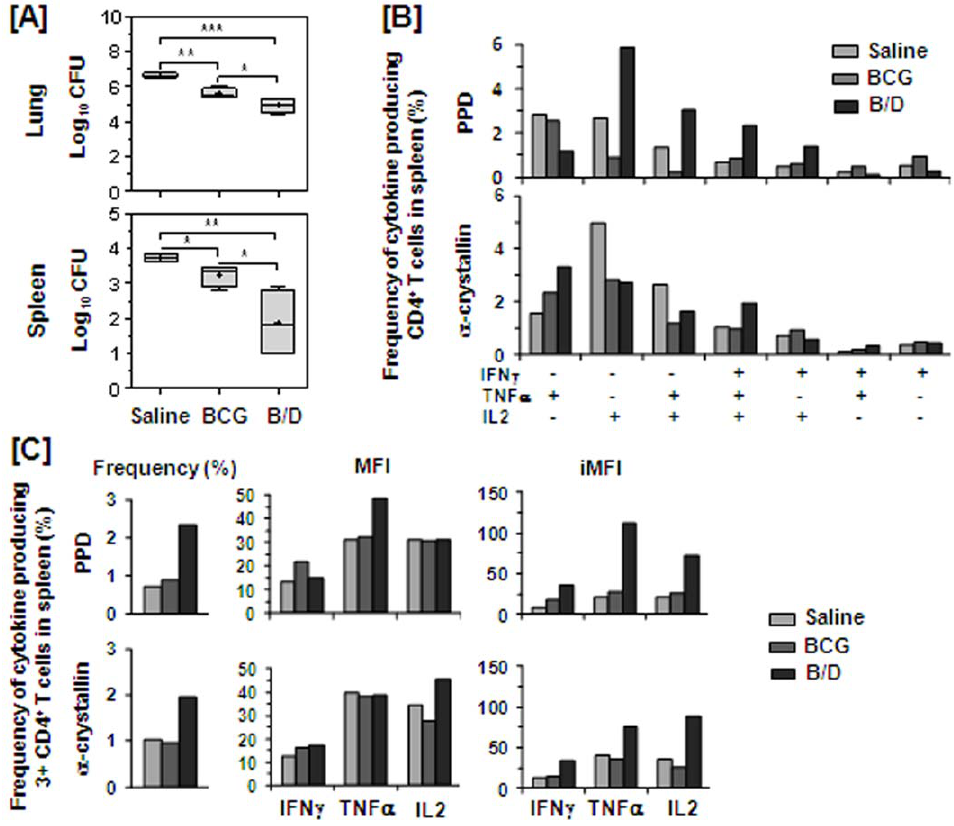
Figure 6. B/D vaccination confers enhanced protection against M. tuberculosis challenge in mice and induces heightened multifunctional CD4 T cell response. The figure depicts (A) the bacillary load in lungs and spleen of mice (n=4) at 4 weeks post-infection and (B–C) multifunctional T cell response at 12 weeks post-immunization. Mice experiment was performed once. (A) Log 10 CFU is represented by box plot (notations are described in the legend of Fig. 1). The lower limit of detection was 1.0 log 10 CFU/g of tissue and animals with undetectable bacilli were allotted a CFU value of 1.0 log 10 /g. *, p , 0.05, **, p , 0.01 and ***, p , 0.001. (One-way ANOVA). (B–C) T lymphocytes were purified from PPD and a - crystallin stimulated splenocytes (pooled from four mice per group) and stained for CD4 T cell surface marker along with intracellular cytokine staining for IFN c , TNF a and IL2 followed by FACS analysis. (B) Represents frequency (%) of PPD and a -crystallin specific CD4 T cells expressing each of the seven combinations of IFN c , TNF a and IL2. (C) Represents frequency of PPD and a -crystallin specific 3 + CD4 T cells along with MFI and iMFI for IFN c , TNF a and IL2. B/D: BCG prime – DNAacr boost regimen.